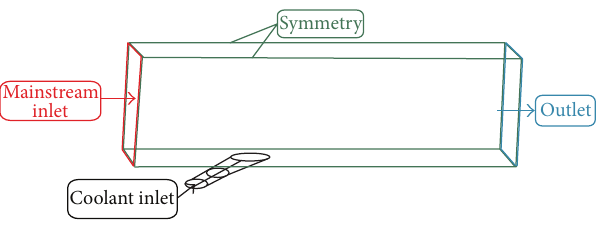
Figure 5: Model boundary conditions.